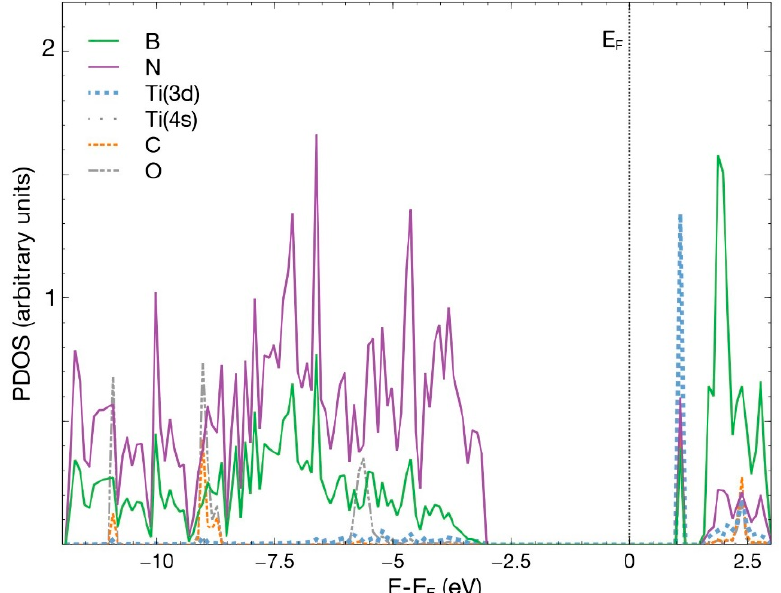
Figure 7. PDOS for the combined system hBN + Ti and the adsorbed CO 2 molecule. The plot shows the p orbitals from all the B, N, C, O atoms and the 3 d and 4 s orbitals from Ti. The contribution from orbital 4 s from Ti is too small to be noticed in the figure.